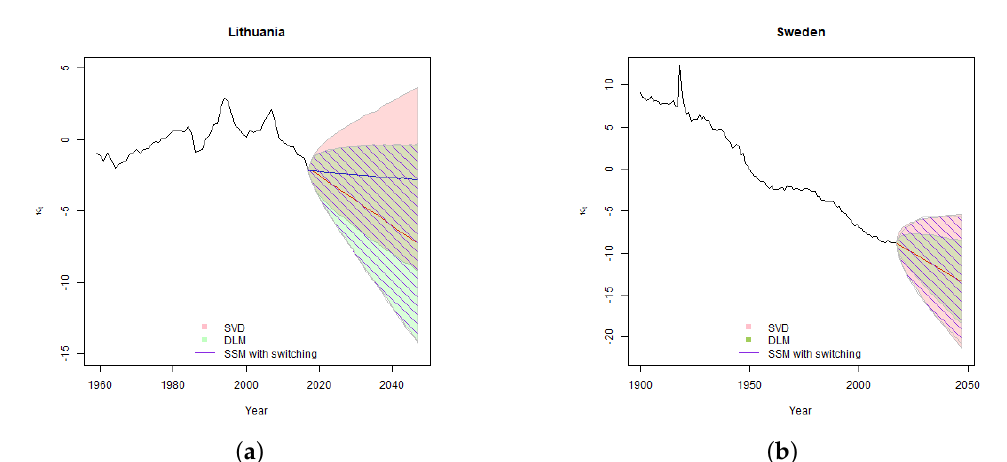
Figure 5. Results of estimation of the Lee-Carter model parameter κ t for Lithuania ( a ) and Sweden ( b ). The shaded region provides 95% simulated confidence intervals of the κ t parameter fitted using SVD, DLM and SSM with switching. In the Lithuanian case, DLM and SSM with switching allow for one-time change in trend in 1995, therefore the direction of the trend differs from SVD estimate. The blue line is used to denote the Lithuanian central forecast estimated with SVD and red line is used to denote SSM central forecast.